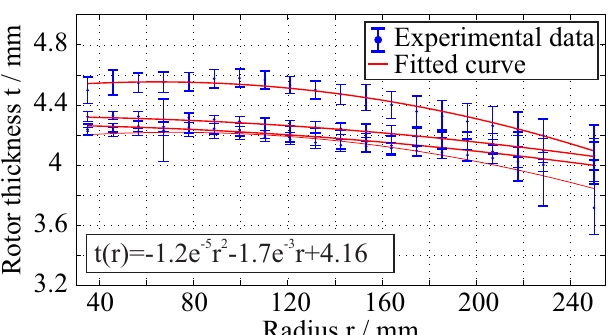
Figure 6. Thickness variation for multiple NCF rotors based on experimental data from the A TOS